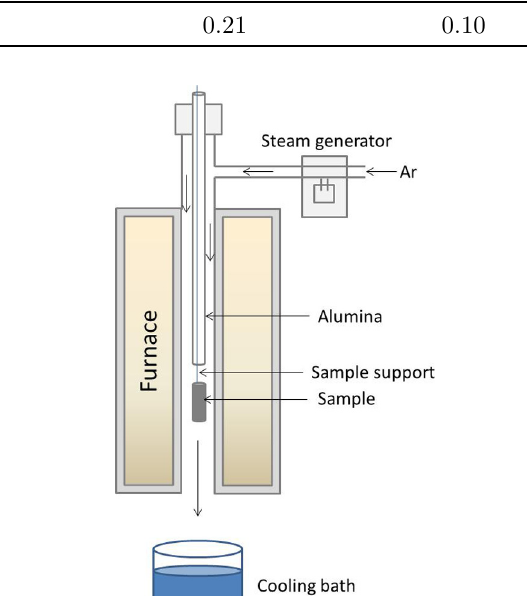
Table 1. Chemical composition of the tested Zircaloy-4. Sn (wt.%) Fe (wt.%)